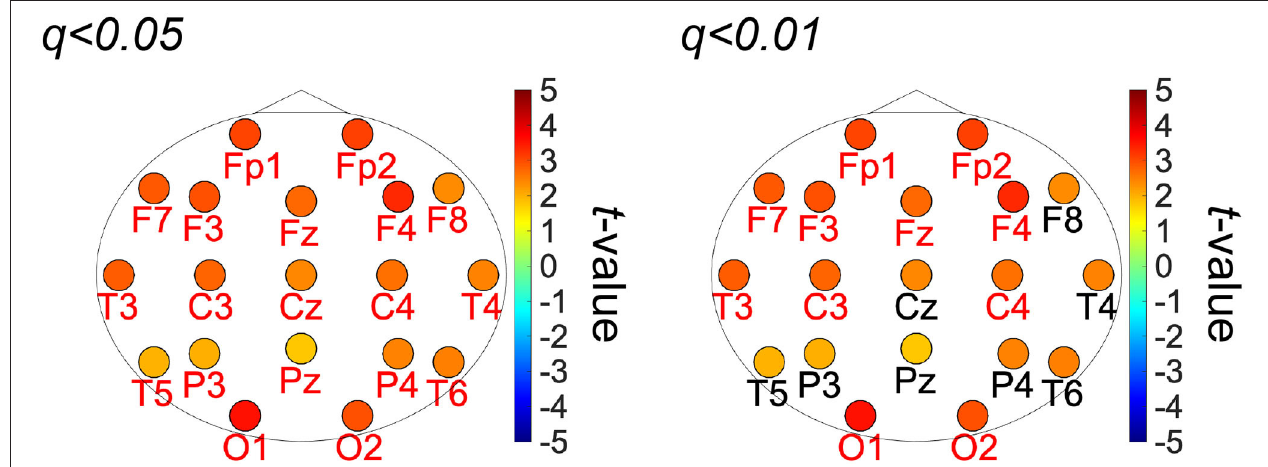
FIGURE 3 | t -values of the topography of the PLI-based node-degree in alpha band in the group-wise comparisons. Warm (cool) color indicates the high-creativity group greater (less) than those of the low-creativity group (labels of electrodes significant after FDR: q < 0.01 (right), 0.05 (left) are highlighted in red).